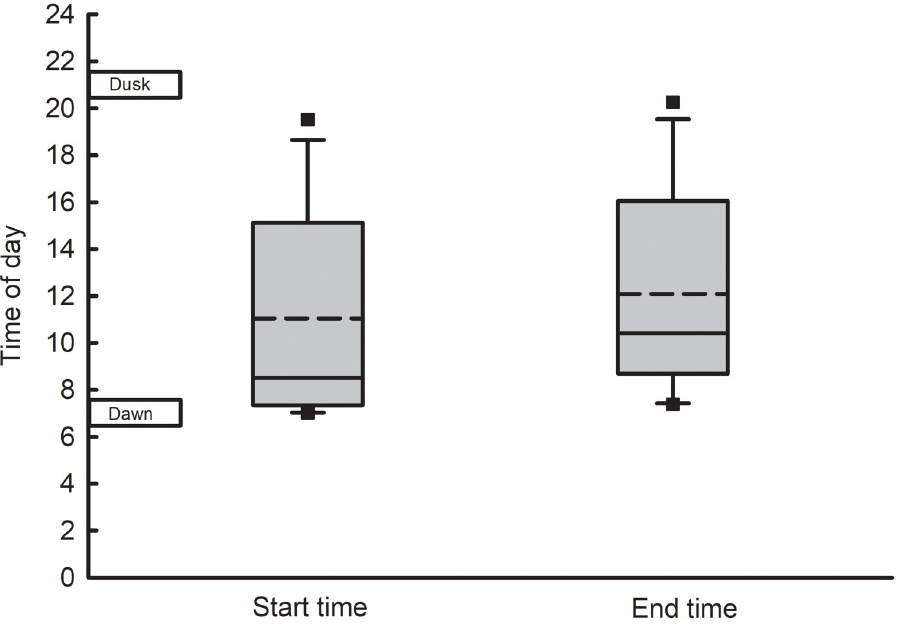
Fig 5. Time of day of longest single flight of western corn rootworm females on flight mills. Includes only females whose longest flight was � 10 min. Dawn is marked at 7 h and dusk is marked at 21 h. The box boundary closest to the x-axis indicates the 25th percentile, solid line within box marks the median, dashed line within box marks the mean, and the boundary farthest from the x-axis indicates the 75th percentile. Whiskers above and below the box indicate the 95th and 5th percentiles, respectively, and outliers are represented as